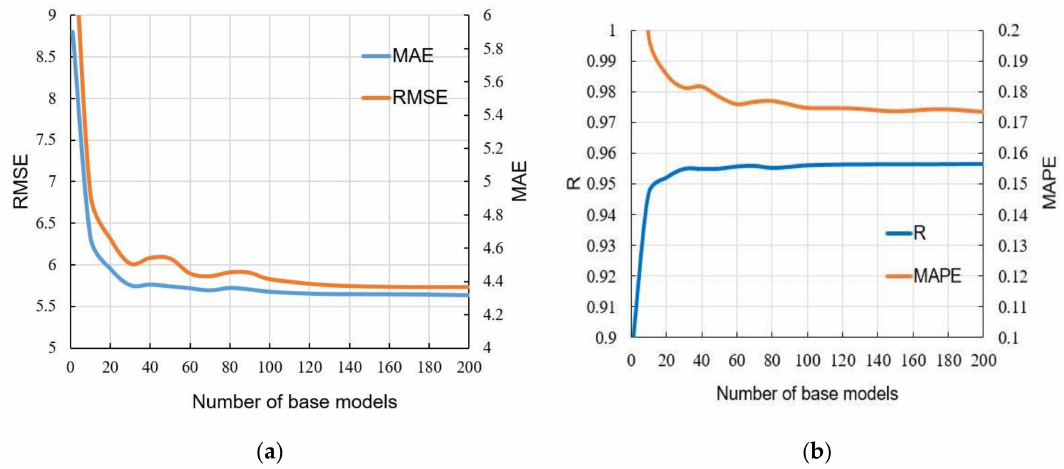
Figure 19. Comparison of accuracy criteria for the ensemble with a different number of individual ANN models within the ensemble: ( a ) RMSE and MAE; and ( b ) R and